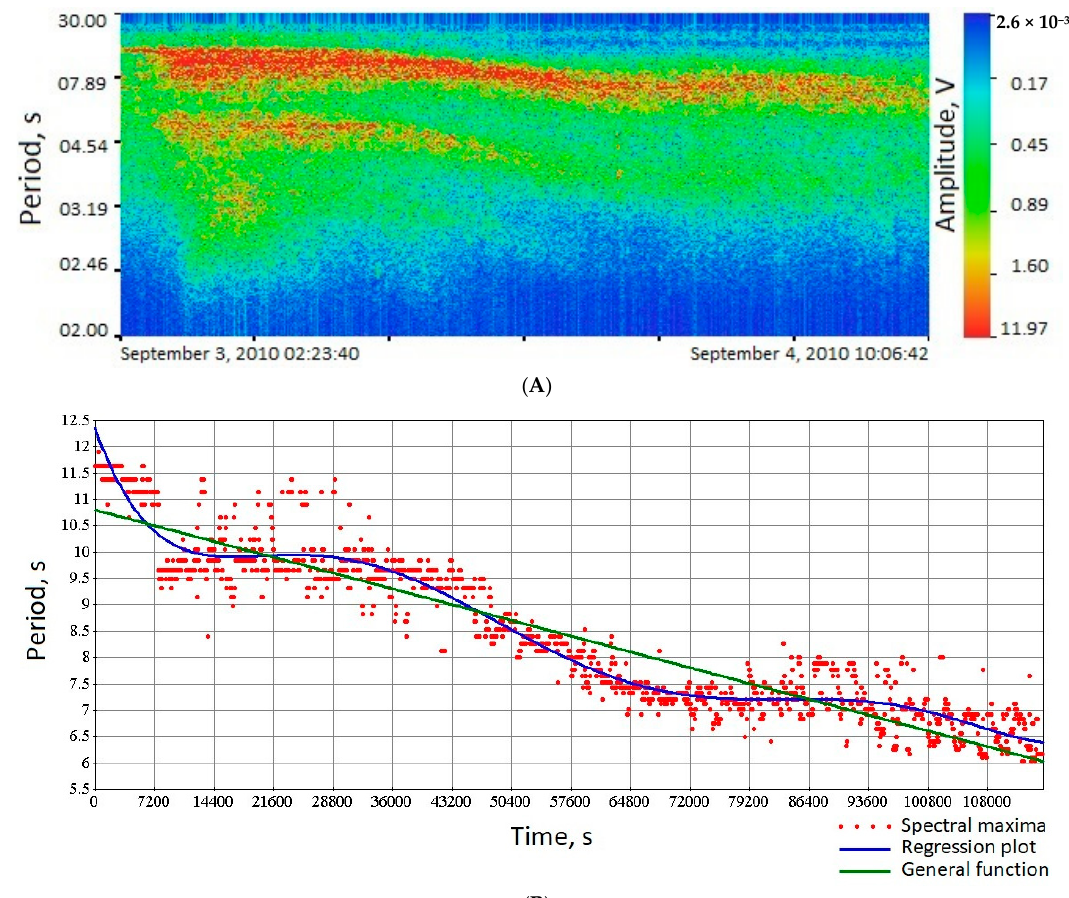
Figure 5. ( A ) Spectrogram of the record of the laser meter of hydrosphere pressure variations located in Vityaz Bay during the KOMPASU typhoon passage and ( B ) regression plot, constructed on the spectral maxima singled out from the signal spectrogram.